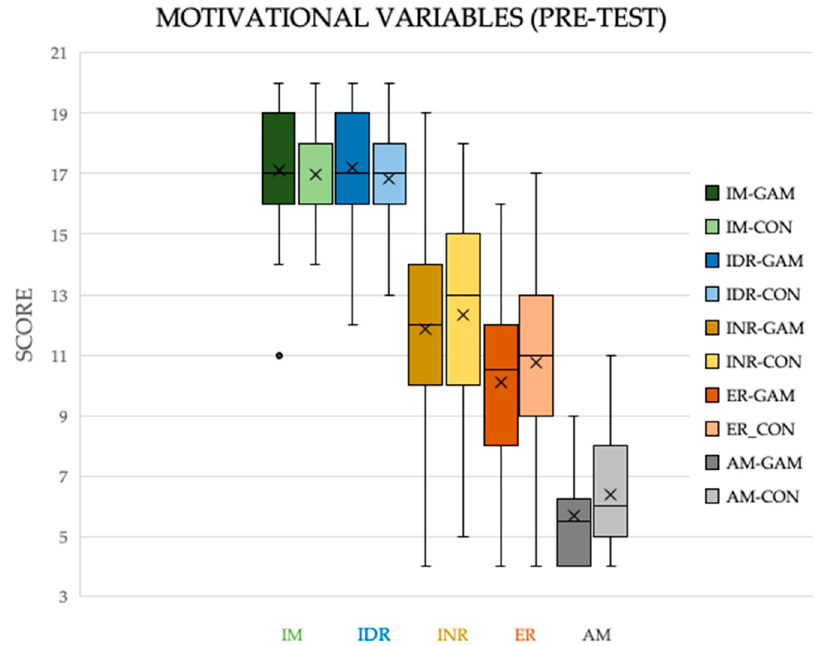
Figure 3. Box diagram of the motivational variables measured in a questionnaire CMEF (pre-test). Note: GAM = experimental group; CON = control group; IM = Intrinsic motivation; IR = Identified Regulation; INR = Introjected Regulation; ER = External regulation; AM = Amotivation.